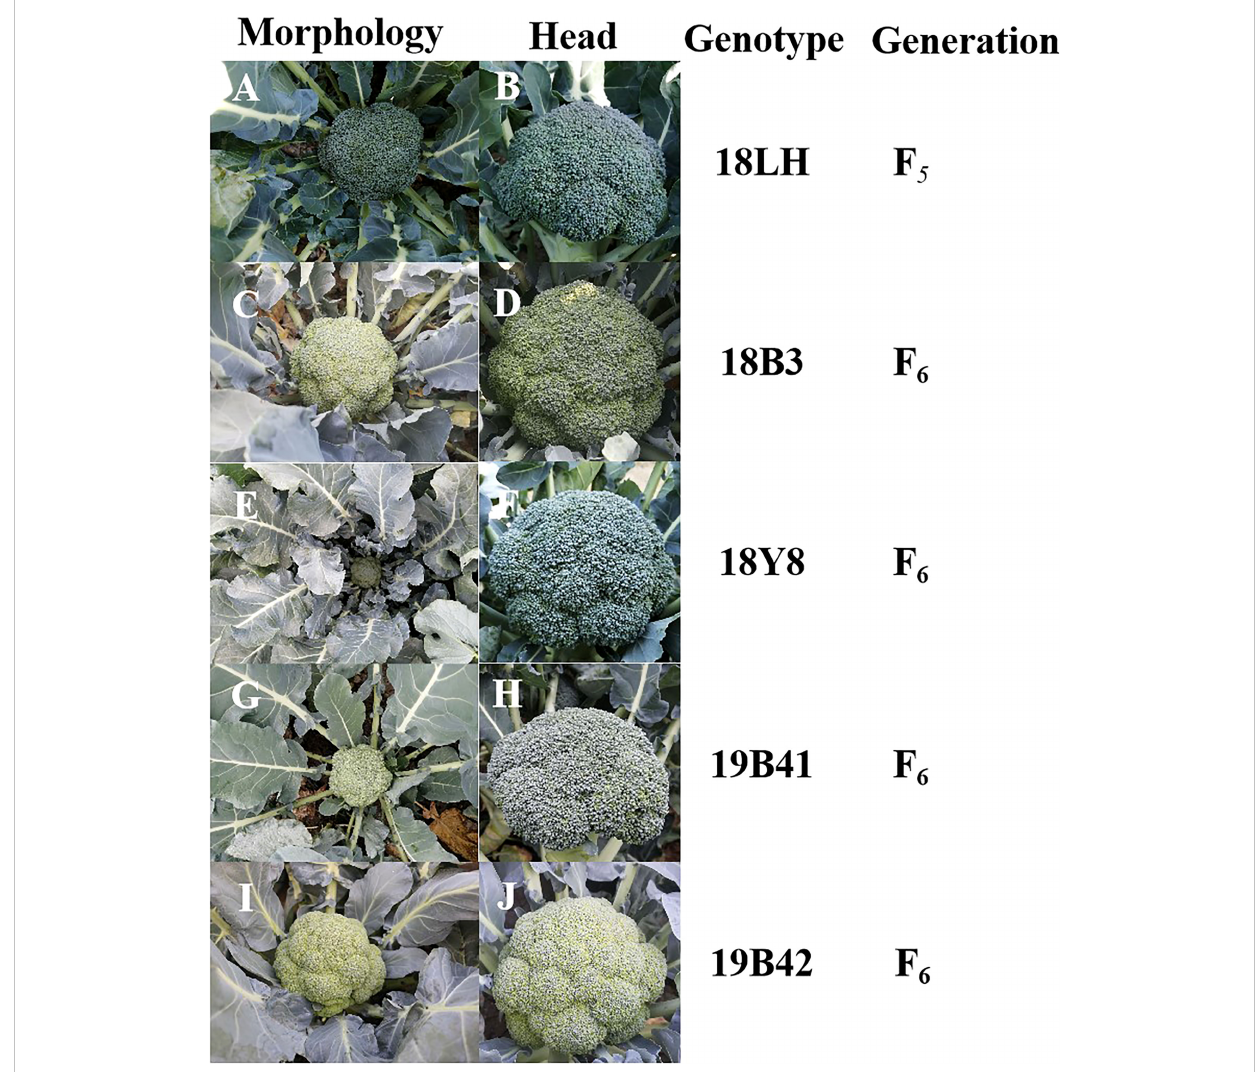
FIGURE 1 The genetic information and pro fi les of 5 broccoli inbred lines. (A, B) Morphology and head image of 18LH genotype broccoli plant. (C, D) Morphology and head image of 18B3 genotype broccoli plant. (E, F) Morphology and head image of 18Y8 genotype broccoli plant. (G, H) Morphology and head image of 19B41 genotype broccoli plant. (I, J) Head and plant pro fi les image of 19B42 genotype broccoli